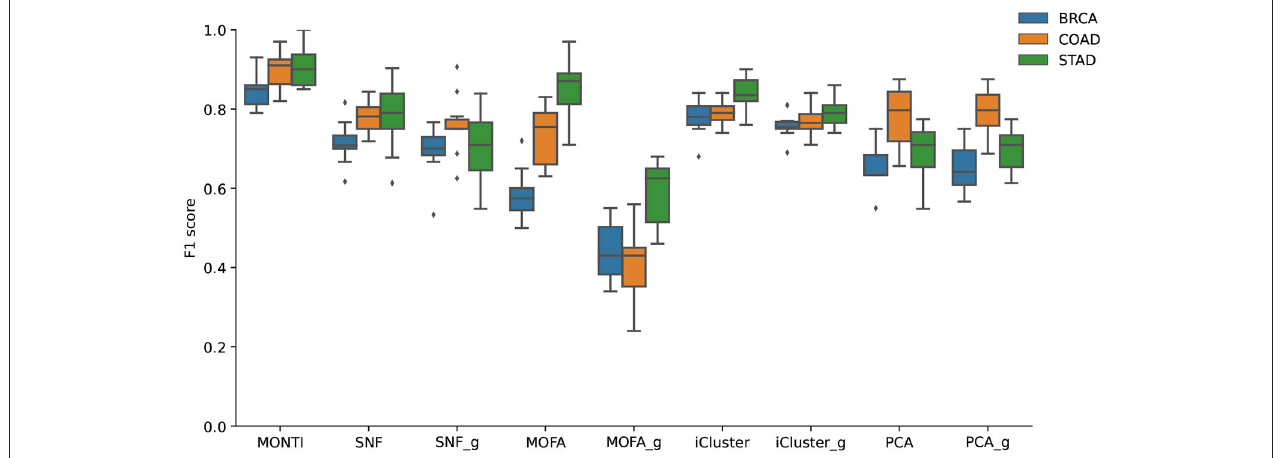
FIGURE 9 | The F1 scores of five tools using gene-level and omics-level data sets of BRCA, COAD, and STAD